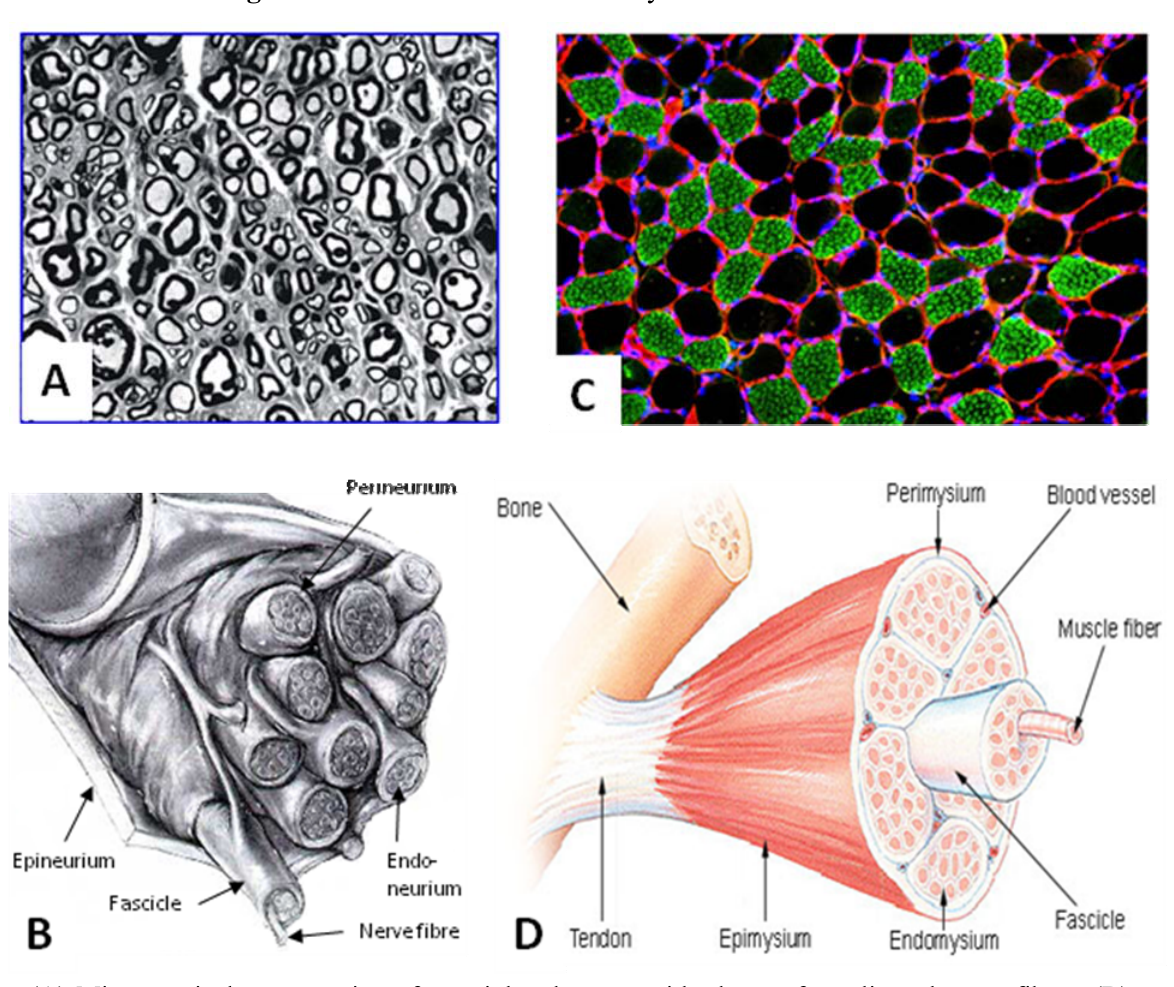
Figure 3. Macro- and microanatomy of a nerve and